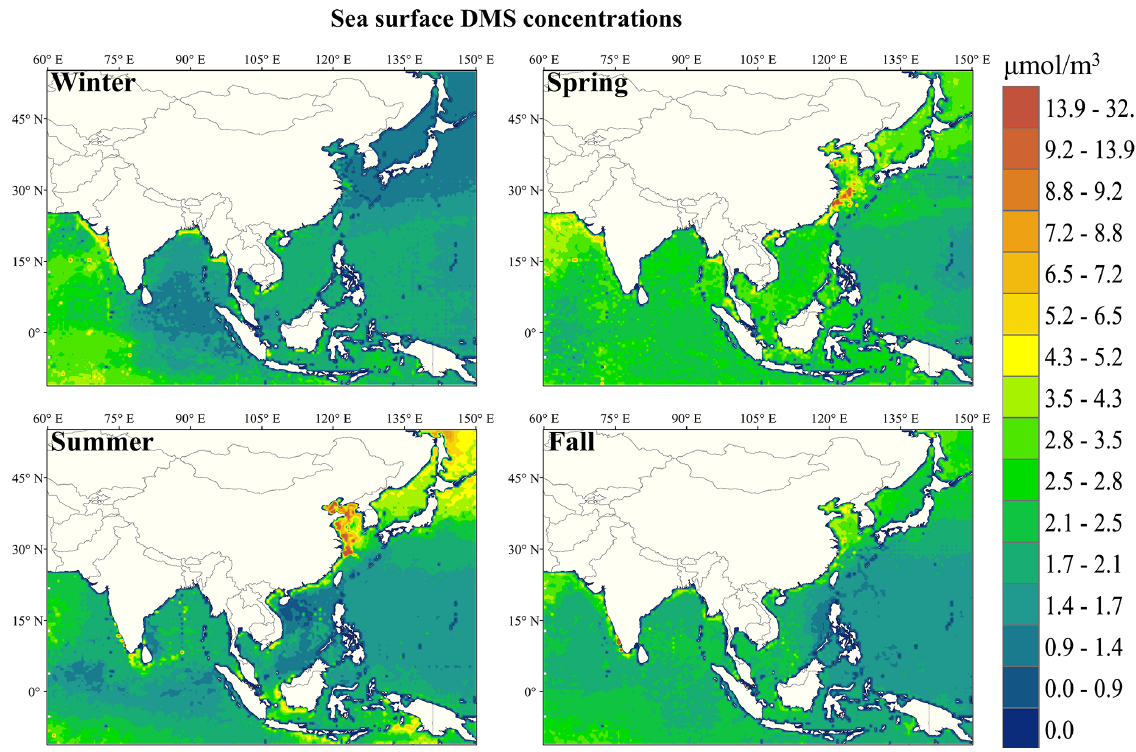
Figure 2. Sea-surface DMS concentrations predicted by the XGBoost model by